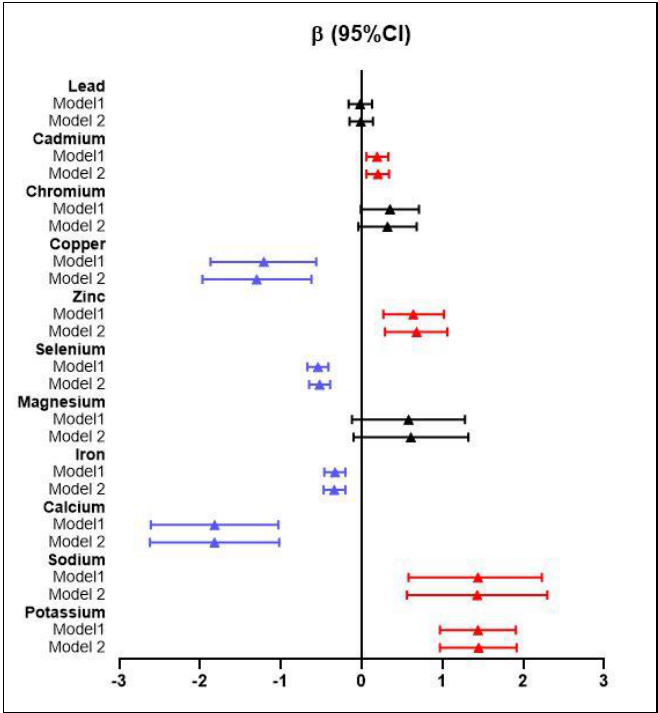
Figure 1. Difference (95%CI) in a yearly decline of eGFR (mL/min/1.73 m 2 ) correlated to baseline plasma metal levels in the linear regression model. CI: confidence interval. Model 1:crude model; Model 2: adjusted for age, gender, baseline eGFR, BMI, smoking status, and drinking status. The inclusion of plasma metal levels in models as natural log-transformed continuous variables. p values were Bonferroni corrected. Red line: Bonferroni-corrected positive significance Blue line: Bonferroni-corrected negative significance.